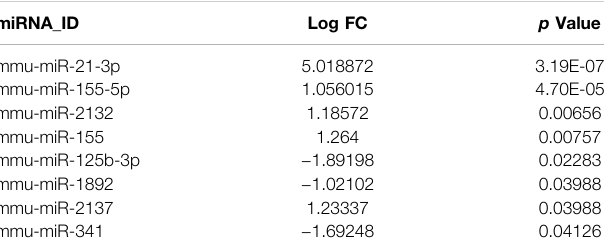
TABLE 3 | Key DE miRs accessed from GSE72380 and